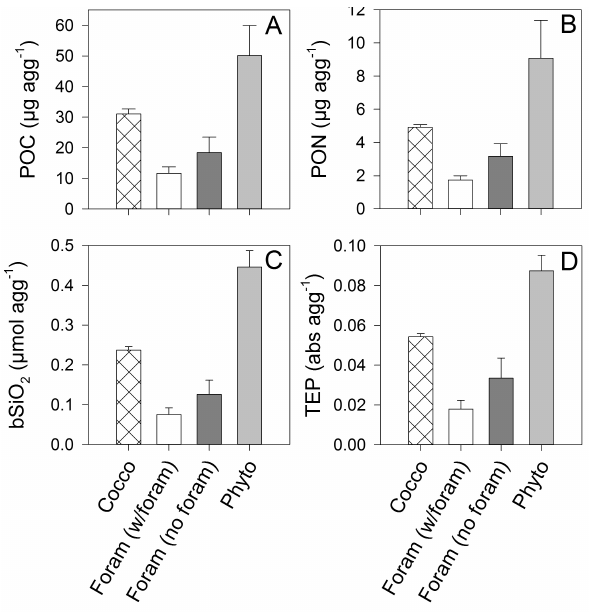
Fig. 2. Frequency of ESDs of aggregates inTank 11 (Phyto), Tank 7 (Foram), and Tank 12 (Cocco). The ESD bins are 0.5mm wide. Fig. 3. Average content of (A) POC, (B) PON, (C) bSiO 2 , (D) TEP per aggregate for the different types of aggregates formed.